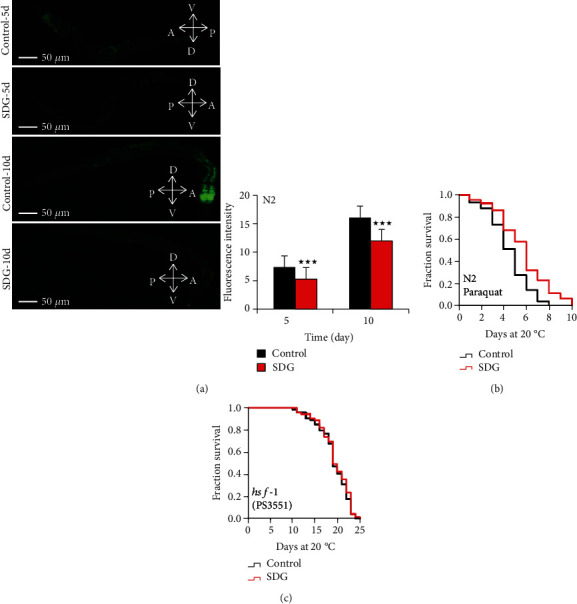
SDG improves the oxidative stress resistance of C. elegans. (a) The measurement of reactive oxygen species (ROS). Worms were observed and photographed using a fluorescent microscope (Leica DM6B) with appropriate filter sets for GFP (magnification: 100x). The quantification of fluorescence intensity showed that SDG could decrease the level of ROS in worms (p < 0.0001, two-tailed t-test). (b) The survival curve of wild-type C. elegans (N2) treated with or without 500 μM of SDG under oxidative stress induced by 20 mM of paraquat. SDG can significantly extend the lifespan of C. elegans by up to 27.0% (p < 0.0001, log-rank test). (c) The survival of hsf-1 mutant strain PS3551 treated with or without 500 μM of SDG at 20°C. SDG could not further extend the lifespan of hsf-1 mutant. A statistically significant p value was calculated by the t-test or log-rank test; ★★★p < 0.0001. The results from repeated experiments and the statistical details are summarized in supplementary Tables S5 and S8.